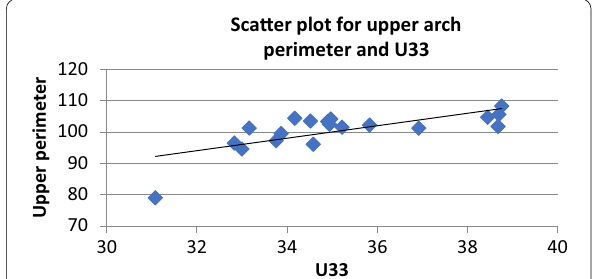
Fig. 3 Scatter diagram showing the correlation between upper arch perimeter and